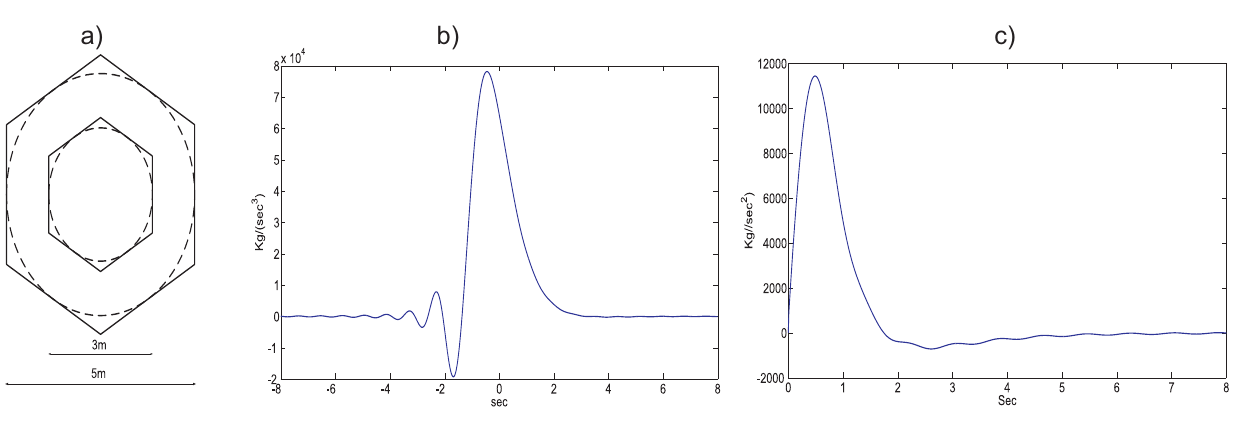
Figure 7. Buoy characteristics. ( a ) Hexagonal torus buoy; ( b ) Excitation impulse